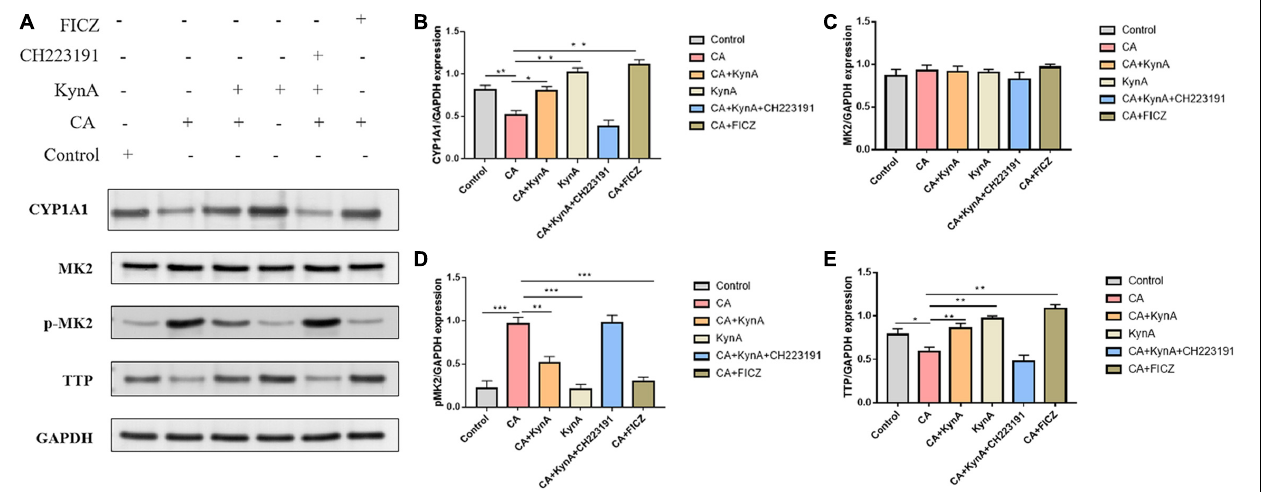
FIGURE 7 | KynA suppressed the MK2/p-MK2 signaling pathway by activating AHR. We investigated the regulation of TTP and expression changes of MK2 and P-MK2 induced by AHR activation at the cellular level. In Caco-2 cells, after treatment with KynA, expression of CYP1A1 increased significantly, as did expression of TTP also ( P < 0.05), while expression of MK2 decreased significantly ( P < 0.05). In the CA- Caco-2 cell model, the expression of proteins CYP1A1 and TTP decreased significantly, but the expression of p-MK2 increased ( P < 0.01). After the treatment of Caco-2 cells with KynA and the AHR agonist FICZ, the expression of CYP1A1 and TTP was significantly increased, but the expression of p-MK2 decreased significantly ( P < 0.01). Treatment with an AHR inhibitor (CH223191) led to a decrease in the expression of CYP1A1 and TTP, and an increase in the expression of p-MK2 ( P < 0.01). Statistical significance was evaluated using the Mann–Whitney U test. P- values < 0.05 (*) or < 0.01 (**) were considered statistically significant. CA, Candida albicans infection; KynA, Kynurenic acid; FICZ, 6-Formylindolo[3,2-b]carbazole. P -values < 0.001